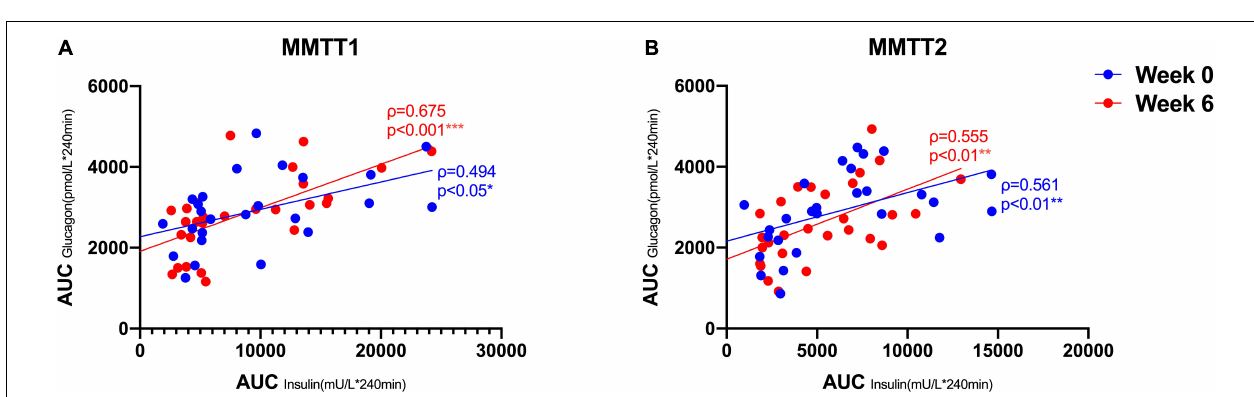
correlation increased markedly after the intervention ( ρ = 0.639, p < 0.001) ( Figure 1F